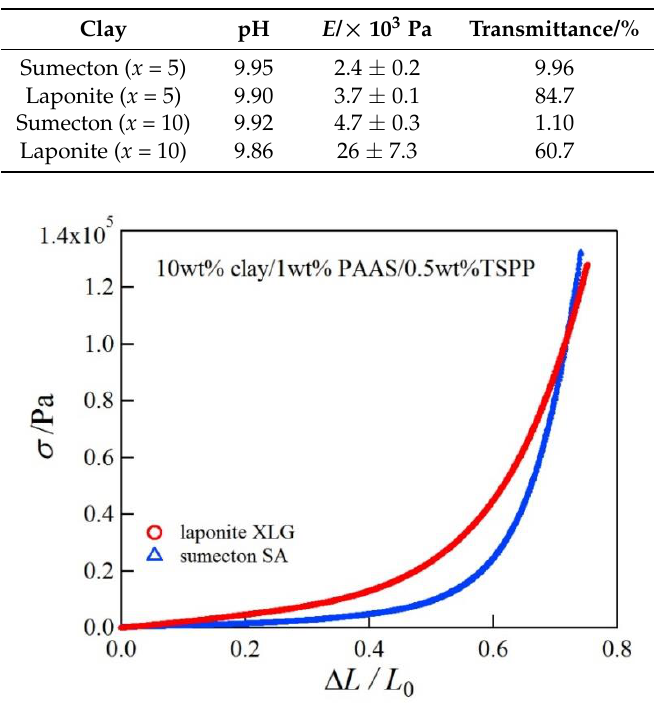
Figure 3. Representative compressive stress–strain curves for 10 wt % laponite/PAAS and 10 wt % sumecton/PAAS blend hydrogels.